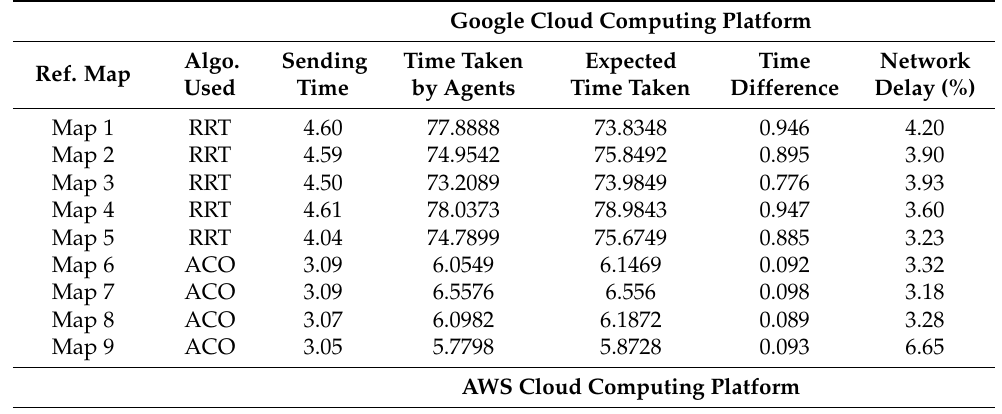
Table 4. Comparison of results obtained, path length, and path time on four different reference maps using cuckoo search algorithm and proposed approach.